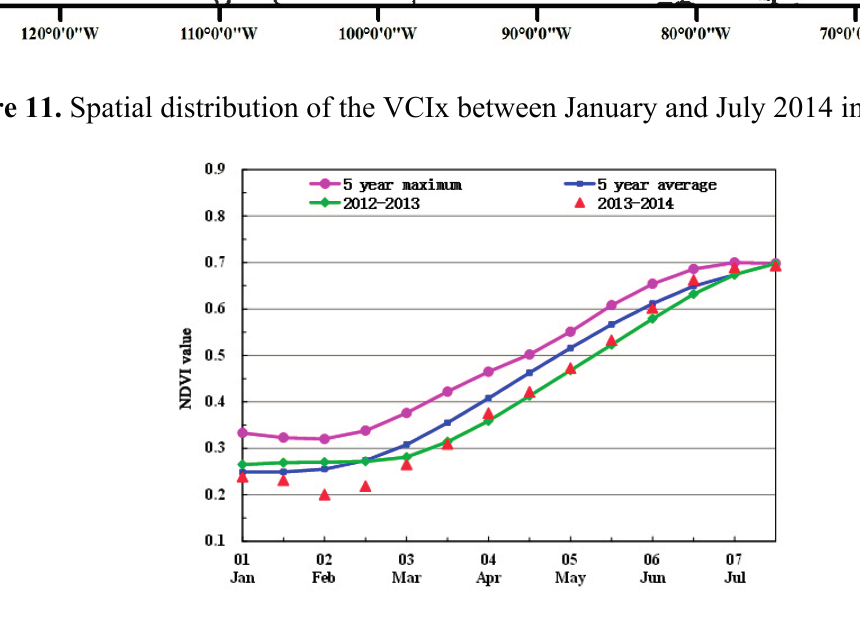
Figure 12. Comparison of various NDVI profiles over the maize, wheat, rice and soybean mask for CONUS.